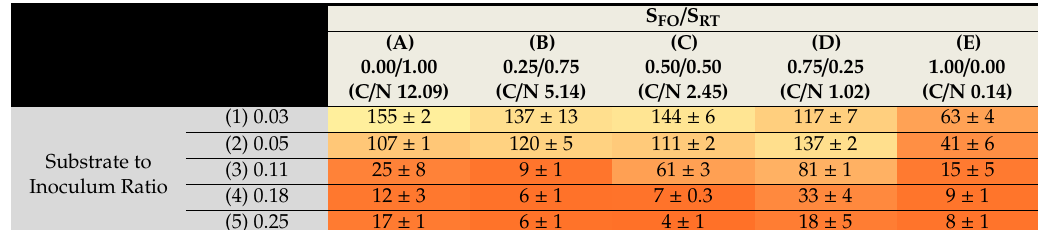
Table 3. Specific methane volume for each substrate combination. The river tamarind mass is decreasing while the fish o ff al mass is increasing, from left to right in the table. The substrate to inoculum ratio is increasing from top to bottom. ( n = 3 ± SD) S FO / S RT is the substrate to inoculum ratio of fish o ff al to river